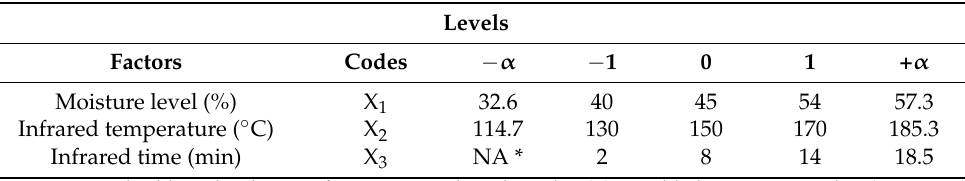
Table 1. Experimental conditions for optimization of moisture and infrared heating conditions (infrared heating temperature and time).